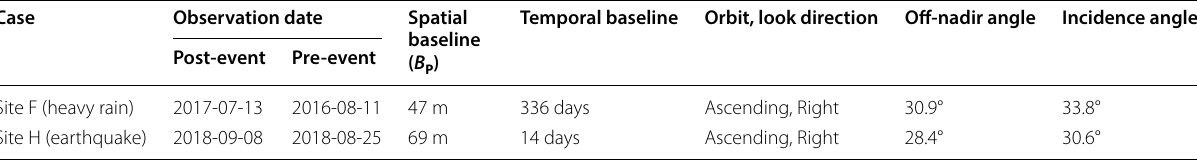
Table 1 ALOS-2 PALSAR-2 data used to detect landslides in this